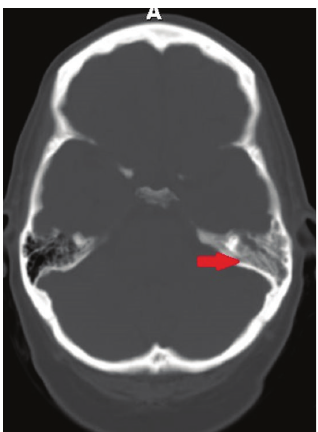
Figure 2: The CT scan shows nonspecific density in the temporal bone without bony erosion (red arrow).